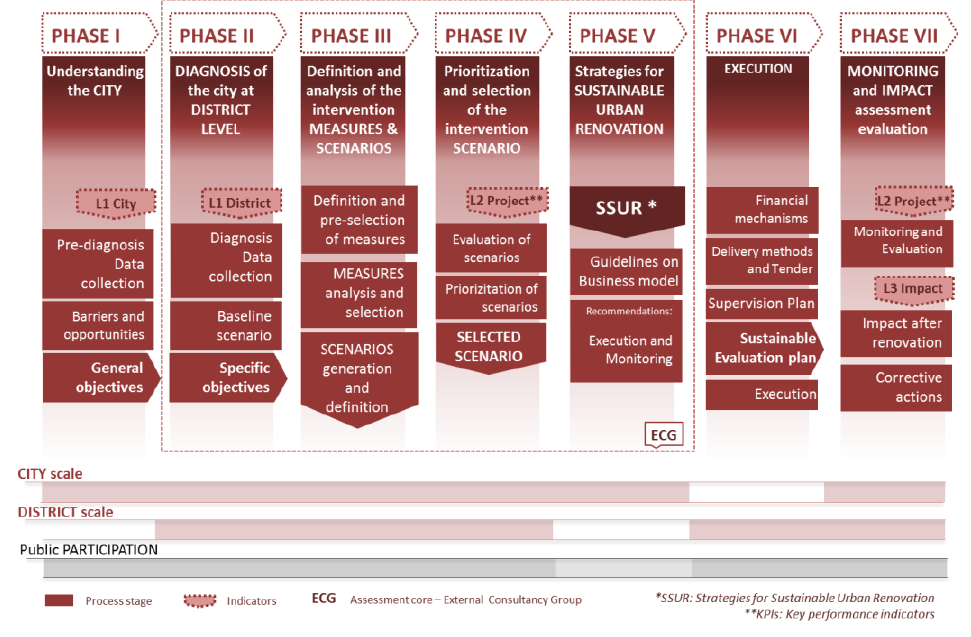
Figure 2. The CITyFiED Methodology approach [ Error! Reference source not found.